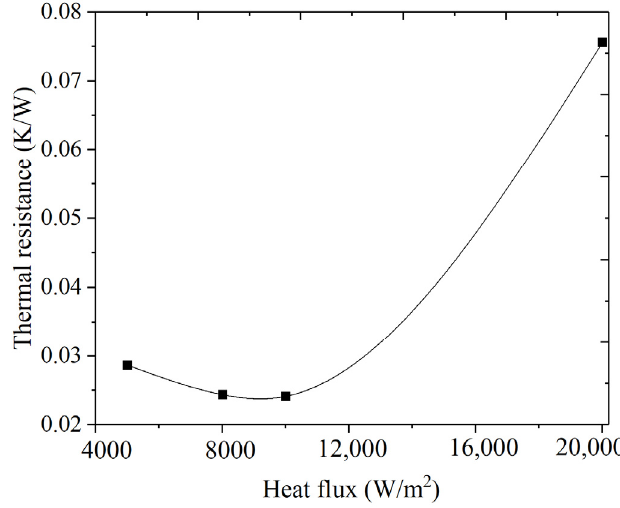
Figure 10. Thermal resistance under different heat input.